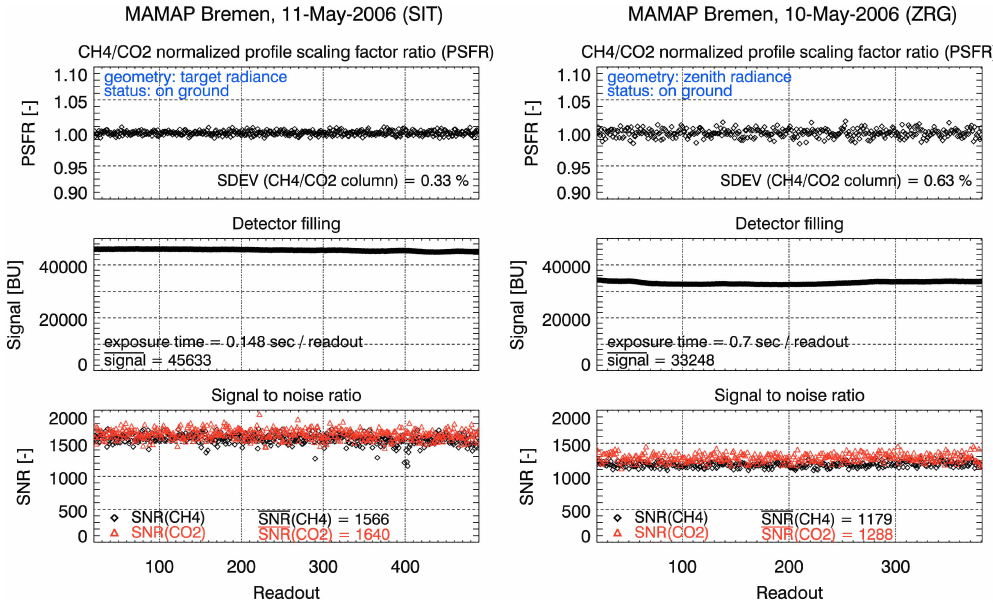
Fig. 8. Analysis of time series of MAMAP CH 4 and CO 2 measurements for slightly variable atmospheric conditions due to thin clouds for the 11 May 2006 stationary “on-ground” sun illuminated target (SIT) measurements. Left: top panel: normalized single readout CH 4 (black) and CO 2 (red) profile scaling factors (PSF). Second panel: normalized single readout CH 4 /CO 2 profile scaling factor ratio (PSFR). Bottom panel: maximum radiance (detector filling) in binary units [ BU ] as measured with MAMAP and digitalized with 16BitADC. Right: as on left side but for 10 readouts co-added to one measurement.